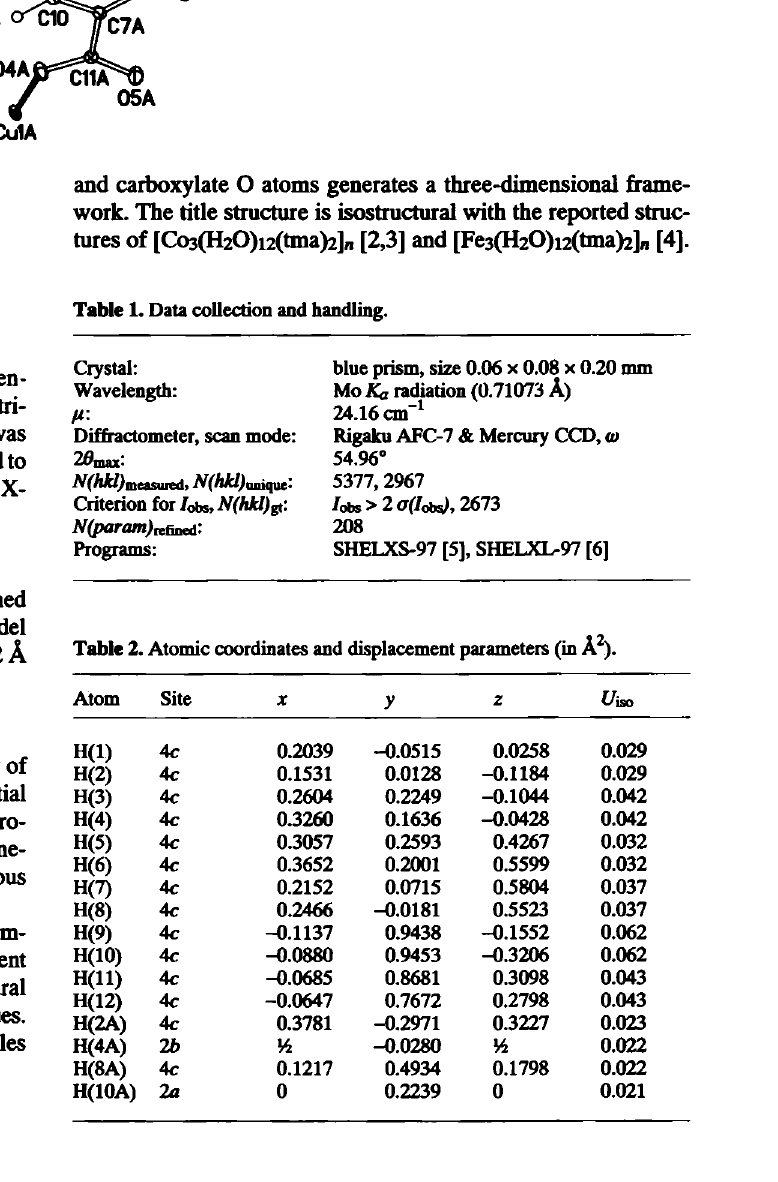
Table 1. Data collection and handling. Crystal: Wavelength: ß- Diffractometer, scan mode: